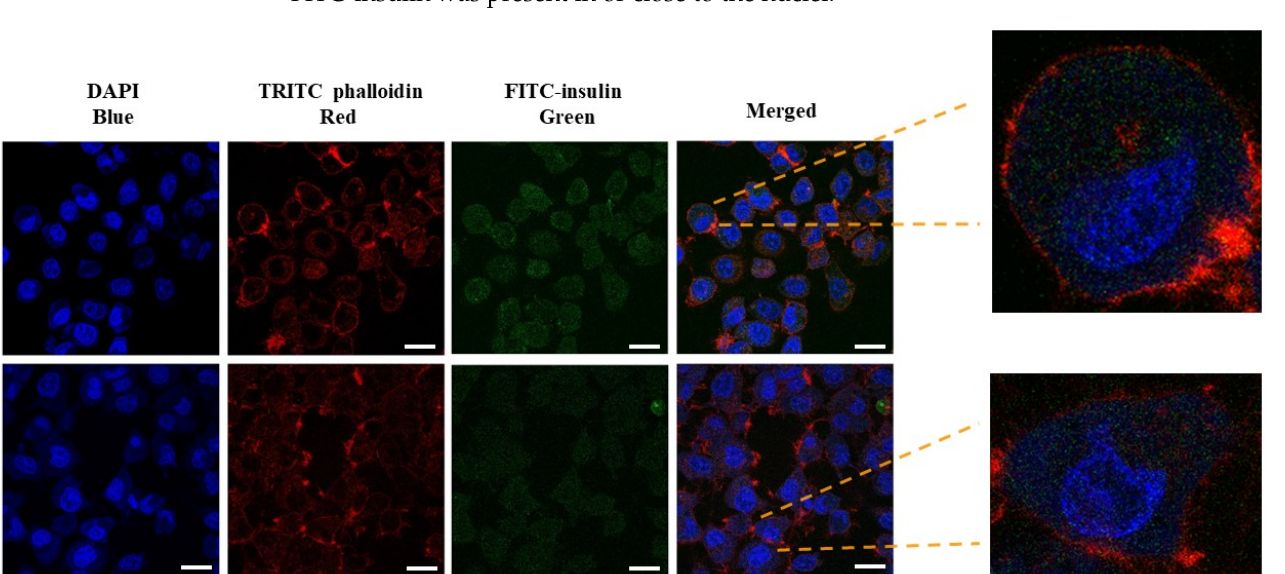
Figure 8. In vitro permeability profiles of IPC-DNVs and IPC-DNV-TSG across TR146 multilayered cells. Table 3. Penetration and transport of formulations ( n = 3). Formulation